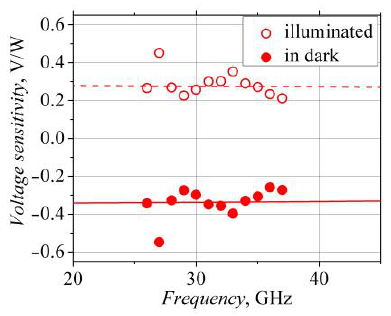
Figure 10. Frequency dependence of voltage sensitivity of the W-diode in the dark and under 14,400 lx illumination. The lines represent theoretical dependence of the voltage sensitivity on frequency in the case of bow-tie diode with semiconductor n-n + junction.